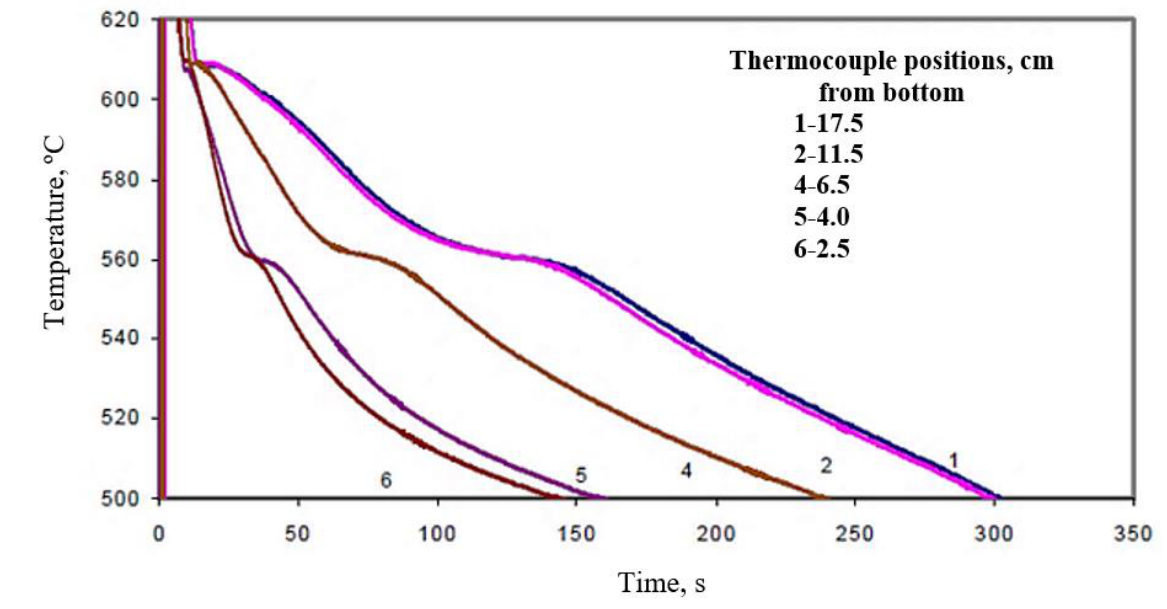
Figure 13. Solidification curves obtained for BB2 alloy (B alloy +2186 ppm Bi, large mold).